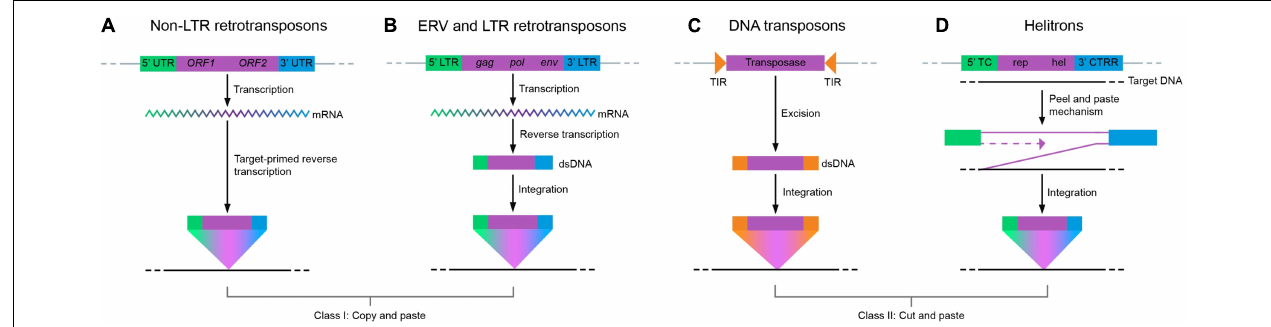
FIGURE 1 | Mechanism of action of the two classes of transposons. Class I TEs mobilize through an RNA intermediate. They can be further divided into two subcategories: non-LTRs (long terminal repeats) and LTRs/ERVs (endogenous retroviruses). (A) A prominent example of a non-LTR retrotransposon is LINE1/L1 (long interspersed nuclear element 1), which uses the process of target-primed reverse transcription carried out by the self-encoded proteins ORF1p and ORF2p. This process involves a nick in the target DNA by an endonuclease followed by reverse transcription and integration, both of which are enabled by the enzymatic activities of ORF2p. (B) ERV and LTR retrotransposons are flanked by LTRs and utilize a double-stranded DNA intermediate (dsDNA) prior to integration into the target site. Class II TEs require excision of genomic DNA with the help of self-encoded transposases. Subsequently, transposases help insert the excised DNA into a target site. (C) DNA transposons excise at the TIR, which is subsequently inserted as dsDNA in the target site. (D) Helitrons transpose by the rolling circle mechanism, involving strand invasion and DNA replication, without excision of the donor transposon